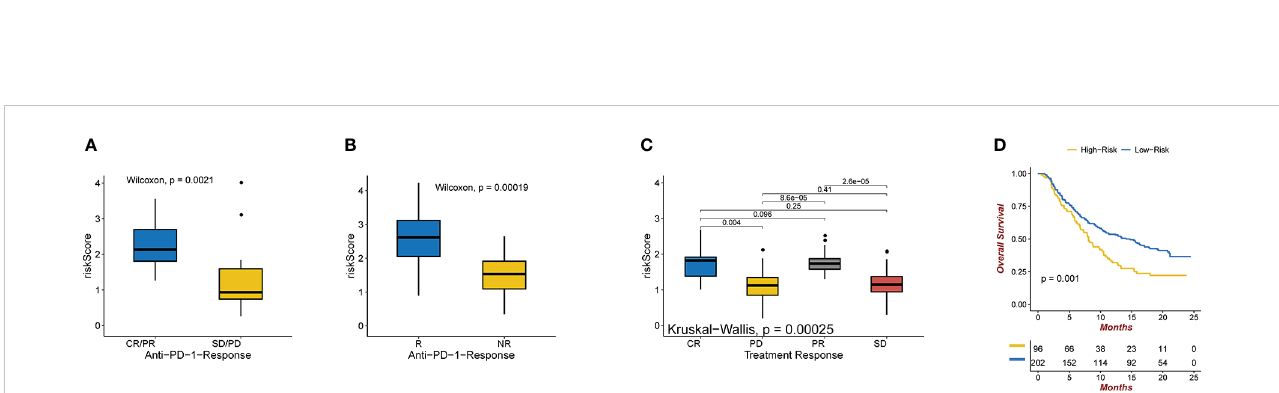
FIGURE 6 (A) Anti-PD-1 clinical response status groups (CR/PR and SD/PD) with varying risk scores. Wilcoxon test was used to compare group differences (P = 0.0021 for Wilcoxon). (B) Immune and genomic correlates of response to anti-PD-1 immunotherapy in glioblastoma(P = 0.00019 for Wilcoxon). (C) Various anti-PD-1 clinical response statuses in groups with varying risk scores (CR, PR, SD, PD). The Kruskal-Wallis test was used to compare group differences (Kruskal-Wallis, P = 0.00025). (D) In the IMvigor210 dataset, Kaplan-Meier curves were created for the two risk score groups. Test of log-rank, P =